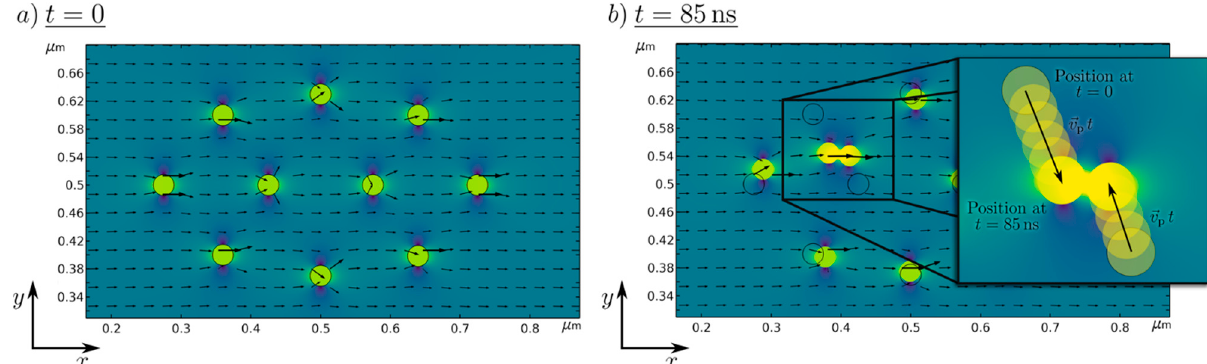
Figure 2. Numerically simulated magnetic scalar potential of 10 Fe 50 Ni 50 nanoparticles in a magnetic field at ( a ) t = 0 s, and ( b ) t = 85 ns. The black arrows represent the magnetic flux density.